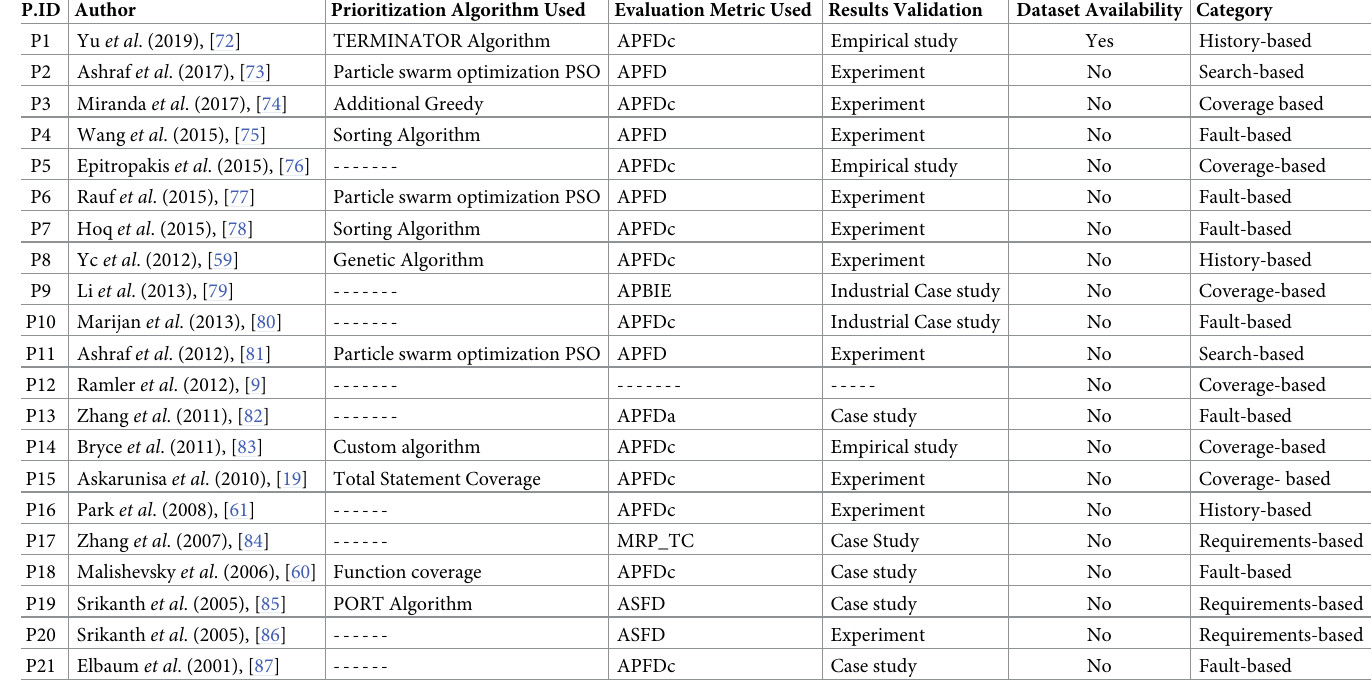
Table 7. Data extraction results.